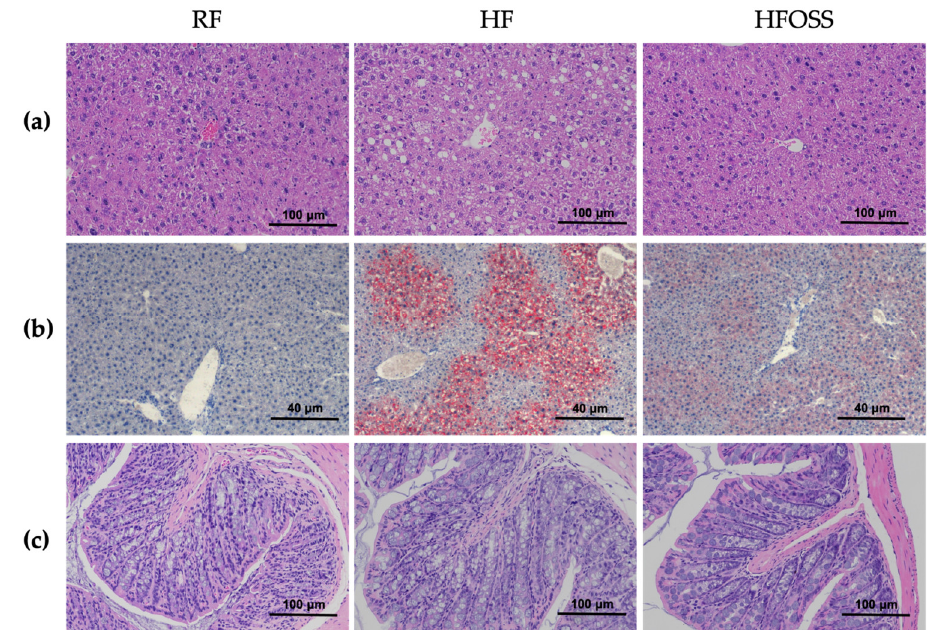
Figure 3. Histopathological analysis of mice fed a regular-fat diet (RF), high-fat diet (HF), and high-fat diet supplemented with OS starch (HFOSS). ( a ) Hematoxylin–eosin (H&E) staining of liver tissues; ( b ) Oil Red O staining of liver tissues; ( c ) H&E staining of colon tissues.